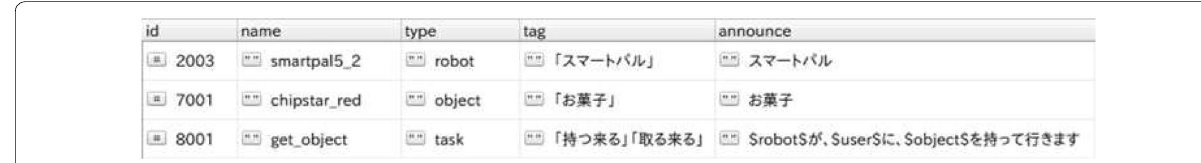
Fig. 11 Robot, object, and task information stored in database